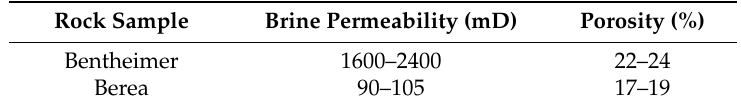
Table 1. Some petrophysical properties of core samples used in the experimental work. Rock